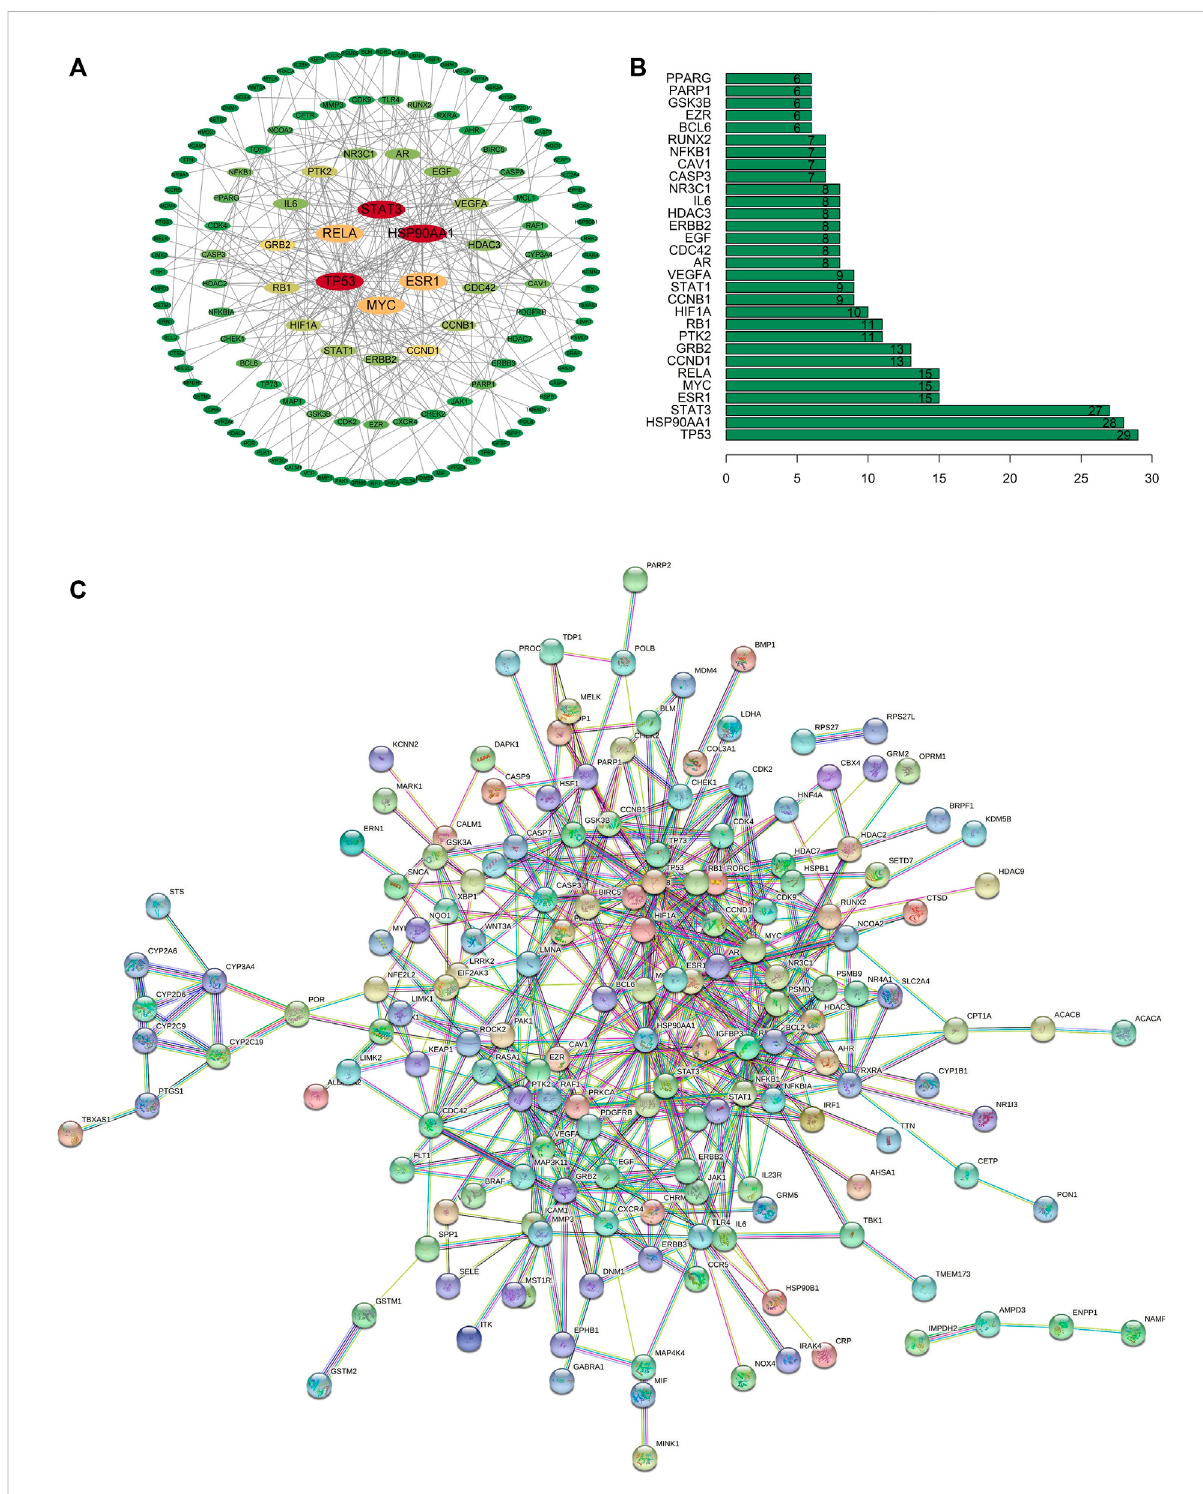
FIGURE 3 (A) PPI network visualized with Cytoscape, the color of each nodes represented degree of freedom. (B) Top 30 of targets were ranked from a histogram. (C) PPI network exported from STRING